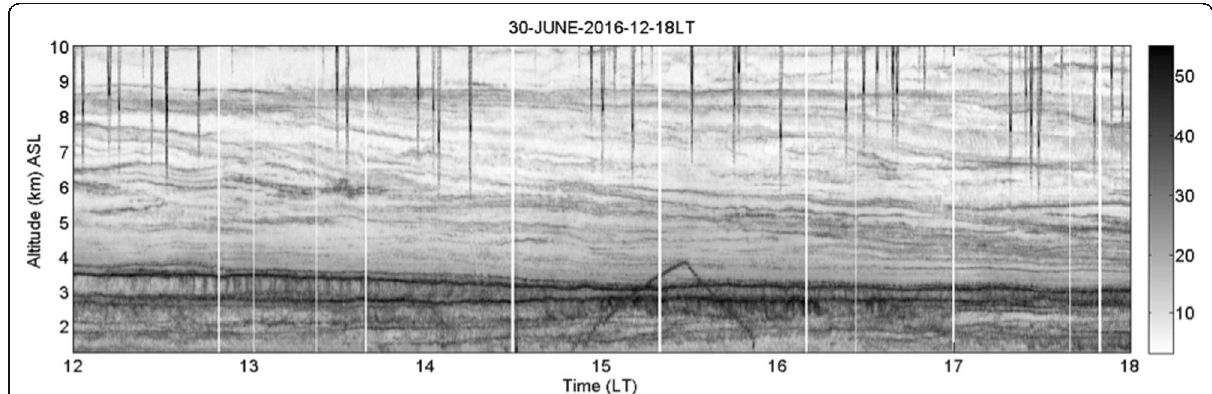
Fig. 2 As in Fig. 1, but on June 30, 2016, from 12:00 to 18:00 LT during the ShUREX 2016 campaign. The striking feature of this radar image is the intrusion of warm, dry air mass over the colder but moist, nearly saturated air adjacent to the ground, leading to the formation of a turbulent “ layer ” sandwiched between two high humidity gradient “ sheets ” at the junction of the two air masses at around 3 – 4 km altitude. The dark vertical lines are commercial aircraft tracks. The inverted V-shaped track in the lower part around 15:30 LT is that of the